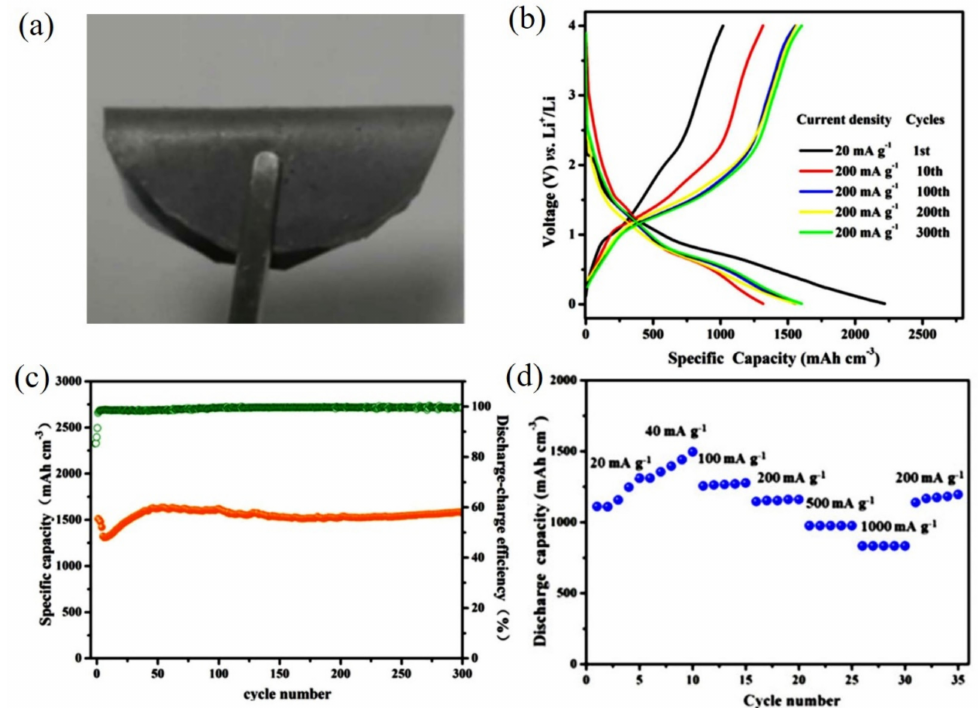
Figure 11. ( a ) The photos of the flexible Te NTs-based electrode under bent state; ( b ) Represen- tative charge–discharge curves of the 1st, 10th, 100th, 200th, and 300th cycles; ( c ) Cycle perfor- mance and Coulombic efficiency at 200 mA g − 1 for 300 cycles, and ( d ) Rate performance in the rate range of 20–1000 mA g − 1 . Reprinted with permission from [53]. Copyright 2021, Licensee MDPI, Basel,